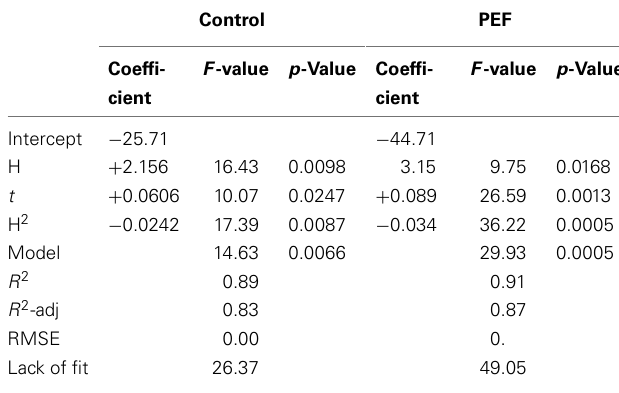
Table 2 | F -value and p -value of significant variables and their interaction of the polynomial equation describing the influence of the percentage of hexane and extraction time on the carotenoid extraction yield (CEY) from tomato peel non-treated (control) and PEF-treated